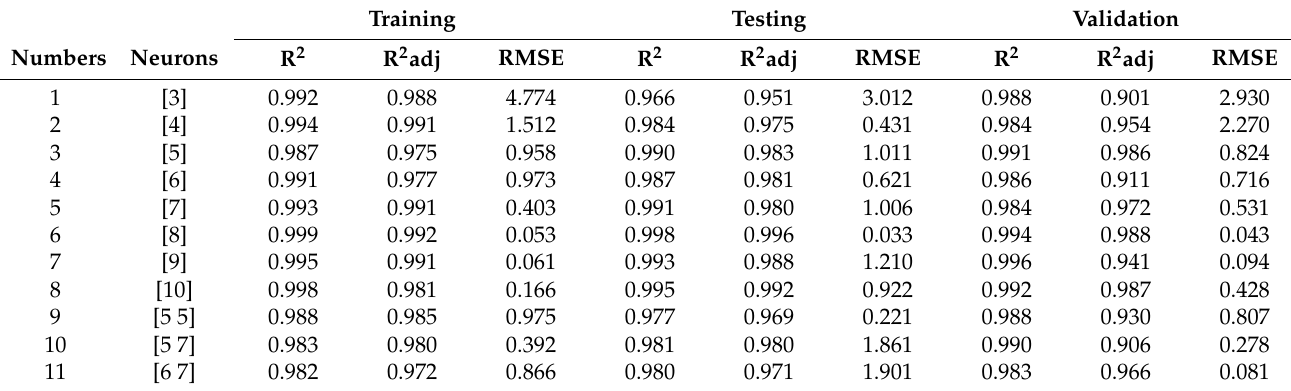
Figure 6. Artificial neural network architecture. Table 5. Optimum conditions for designing the ANN prediction